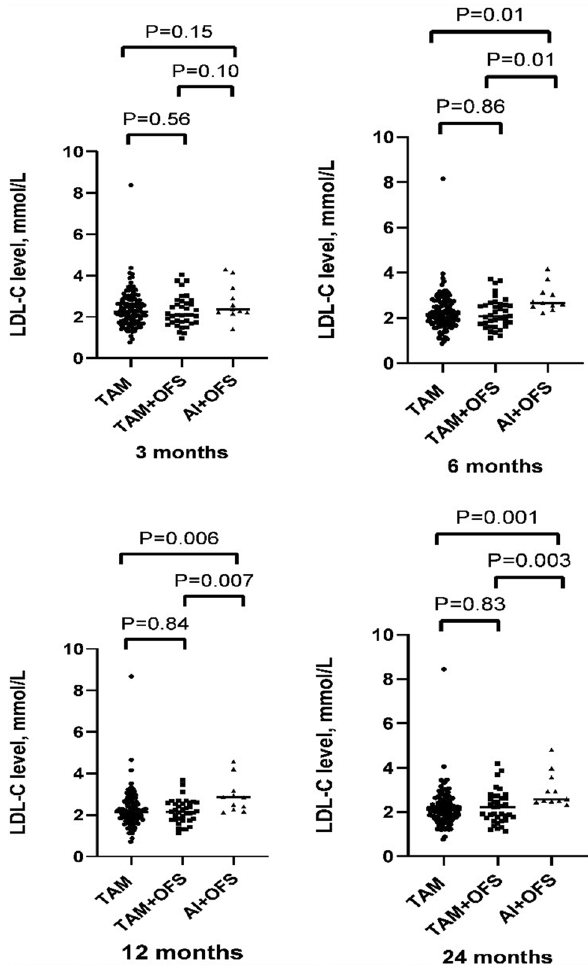
Figure 2. Low-density lipoprotein cholesterol (LDL-C) levels between different